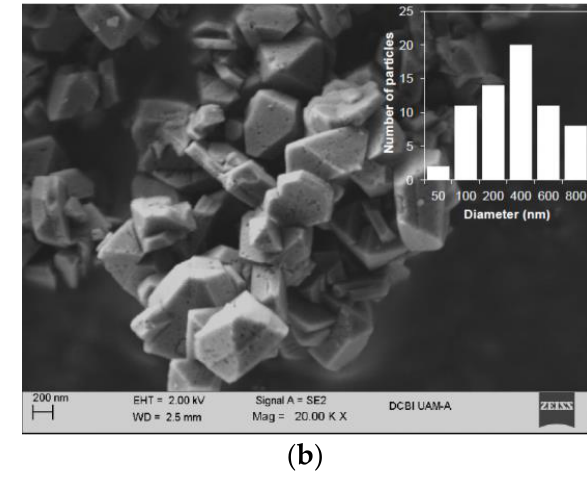
Figure 5. ( a ) N 2 physisorption isotherms, and ( b ) distribution of pore sizes of the Y ‒ type zeolites. Additionally, the pore volume increased from 0.21 cm 3 /g to 0.287 cm 3 /g with the increment in the Si/Al ratio from 7 to 45 (Table 1). The samples showed a proportion of micropores and small mesopores (2–3 nm) besides a mesoporous system with pore sizes between 5 nm and 40 nm.